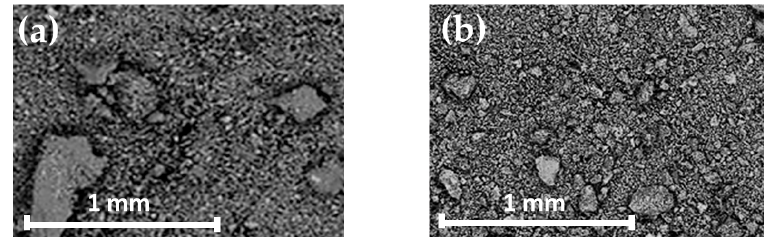
Figure 1. SEM-EDS image of ( a ) BA and ( b ) FA (before grinding). Table 1. Elements constituting BA and FA. n.a.: not available. Bottom ash (BA)